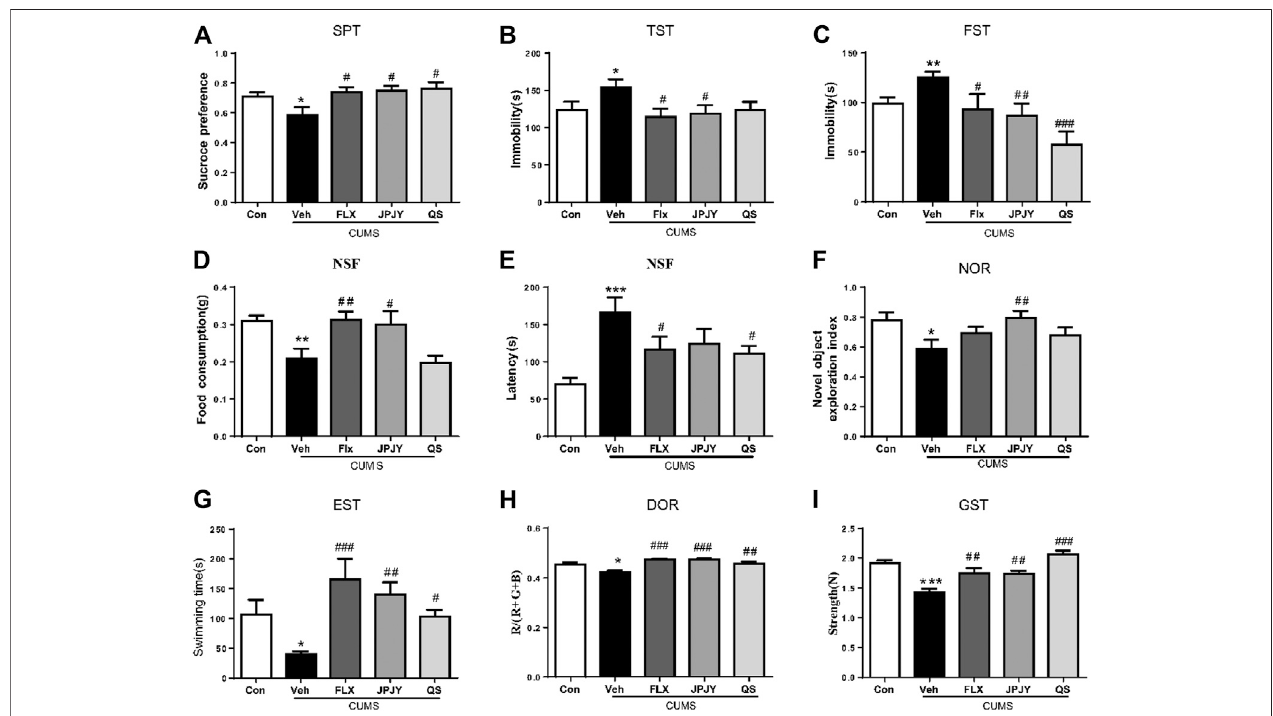
FIGURE 2 | The anti-fatigue and antidepressant behaviors following drug administration in mice exposed to chronic mild stress. Mice were exposed to chronic unpredictable mild stress (CUMS), and received treatment of Veh (Vehicle), FLX, JPJY and QS. Control (Con) mice were not exposed to stress but received vehicle treatment. Behaviors were tested in 2 days after drug administration. (A) Group difference in sucrose preference test [F (4, 57) (cid:2) 3.268, p < 0.05 and n (cid:2) 11 – 15]. (B,C) Group difference in immobility time in TST [F (4, 41) (cid:2) 2.875, p < 0.05 and n (cid:2) 8 – 12] or FST [F (4, 47) (cid:2) 5.849, p < 0.05 and n (cid:2) 9 – 12]. (D,E) Group difference in latency [F (4, 54) (cid:2) 6.003, p < 0.05 and n (cid:2) 9 – 15] and food consumption [F (4, 50) (cid:2) 6.114, p < 0.05 and n (cid:2) 9 – 15] in NSF test. (F) Group difference in new object recognitionindexinNOR[F(4,52) (cid:2) 2.633, p < 0.05and n (cid:2) 11 – 12]. (G) Groupdifferenceinlatencyinexhaustedswimtest[F(4,44) (cid:2) 5.009, p < 0.05and n (cid:2) 9 – 11]. (H) GroupdifferenceinRGBsummedvaluedividedbyRvalueindegreeofredness[F(4,40) (cid:2) 8.946, p < 0.05and n (cid:2) 8 – 10]. (I) Groupdifferenceinstrengthingripstrength [F (4, 62) (cid:2) 15.96, p < 0.05 and n (cid:2) 11 – 15]. One-way ANOVA, * p < 0.05, ** p < 0.01, *** p < 0.001 vs. CTL; # p < 0.05, ## p < 0.01, ### p < 0.001 vs. Veh. Data represent means ±